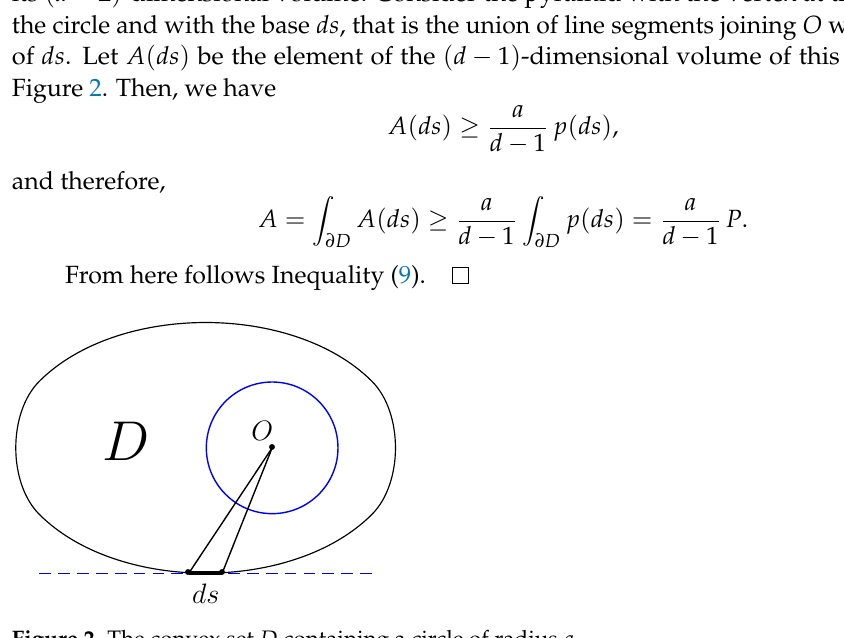
Figure 2. The convex set D containing a circle of radius a Figure 2: The convex set D containing a circle of radius a .